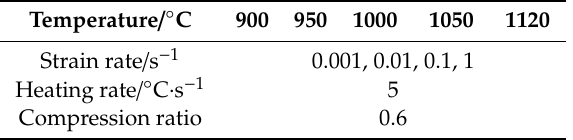
Figure 1. The original microstructure of the GH4169 forge piece. Table 1. Deformation parameters for the GH4169 superalloy hot compression experiment.